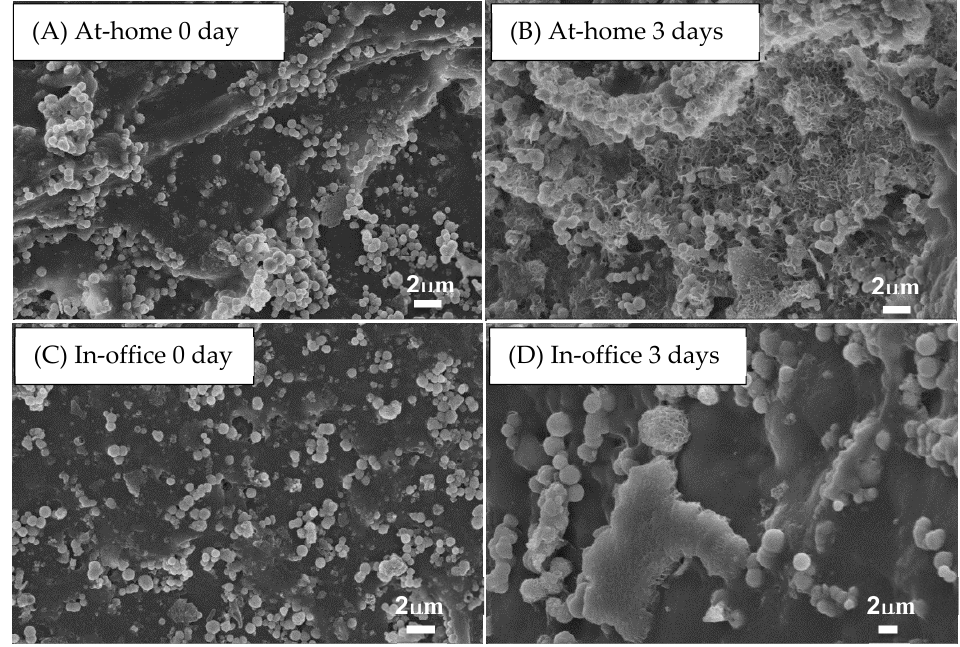
Figure 6. Morphology of bleached teeth surface after being rinsed in 2 mL phosphate buffer solution (PBS) at 37 °C for 0 days ( A , C ) and 3 days ( B , D ). (A, B) and (C, D) were bleached by at ‐ home gel and in ‐ office gel, respectively.